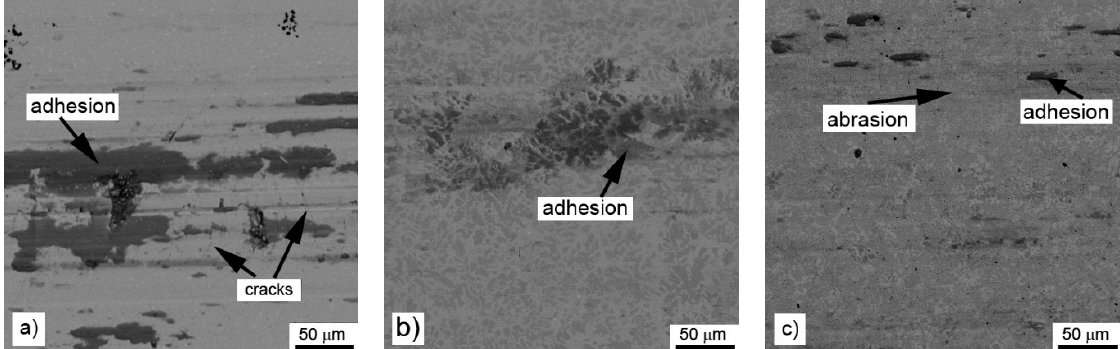
Figure 11. Wear tracks on aluminothermically prepared samples after testing with 100Cr6 steel ball as the static part-